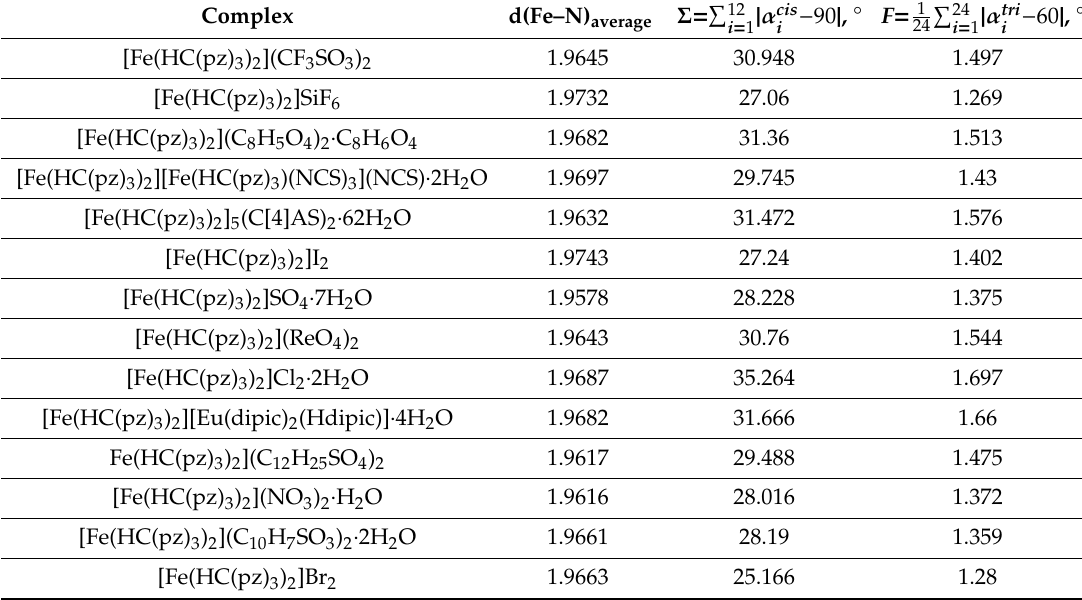
Table 1. Basic geometric characteristics of the iron(II) environment in complexes at T = 150 K.